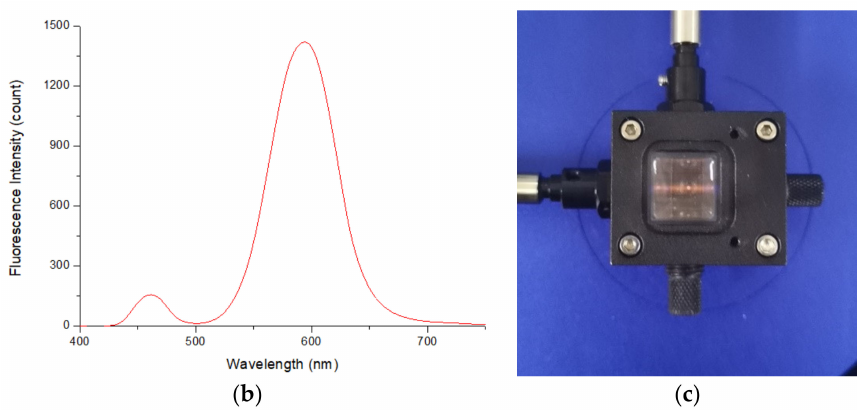
Figure 2. ( a ) Relationship between the fluorescence intensity of a QD solution without etching and time. Concentration of Tris-HCl bu ff er solution: 10 mmol / L. pH of Tris-HCl bu ff er solution: 8.5. Concentration of added QD solution: 5 µ mol / L. Addition order: Tris-HCl bu ff er solution (2 mL) → QD solution (0.4 mL) → Tris-HCl bu ff er solution (1.6 mL). Excitation wavelength: 460 nm. Observation time: 10 min. ( b , c ) The fluorescence response of a QD solution without etching. Concentration